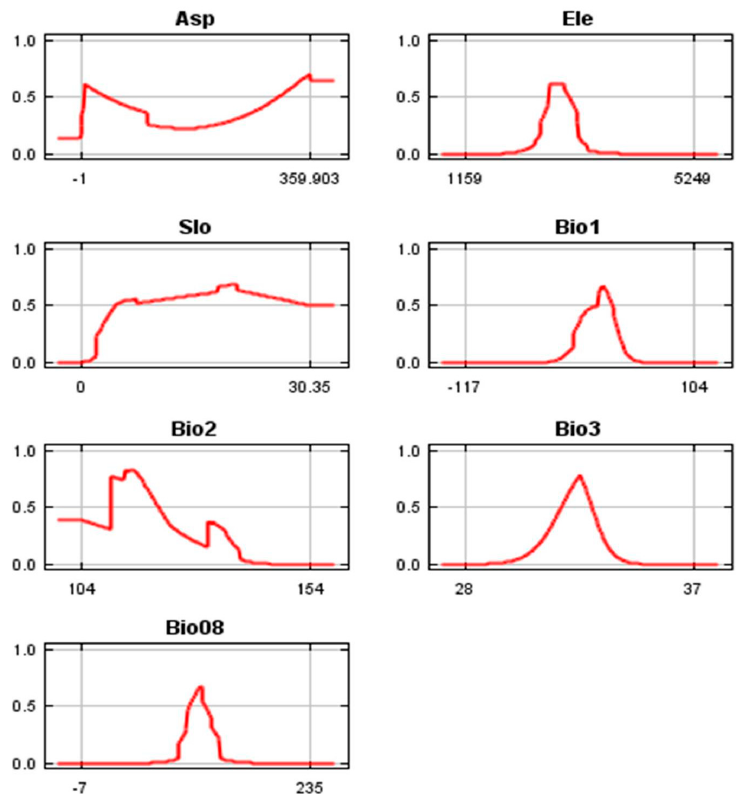
Figure 3. Response curves of seven environmental variables in Qinghai spruce’s habitat distribution model. Bio1: Annual Mean Temperature (°C *10); Bio2: Mean Diurnal Temperature Range (Mean of monthly (max temp minus min temp)) (°C *10); Bio3: Isothermality (P2/P7) (*100), Bio8: Mean temperature of wettest quarter (°C *10); Ele: elevation (m); Asp: aspect (°); Slo: slope (°).